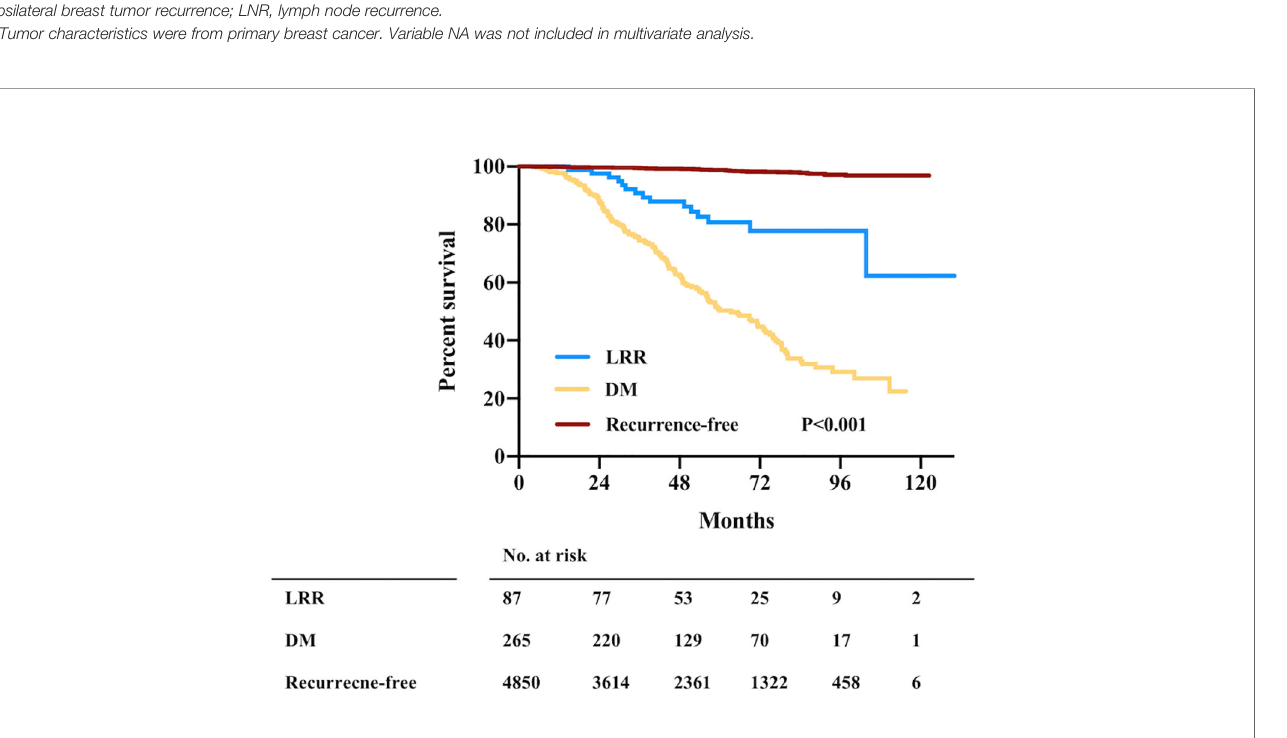
Multivariate analysis